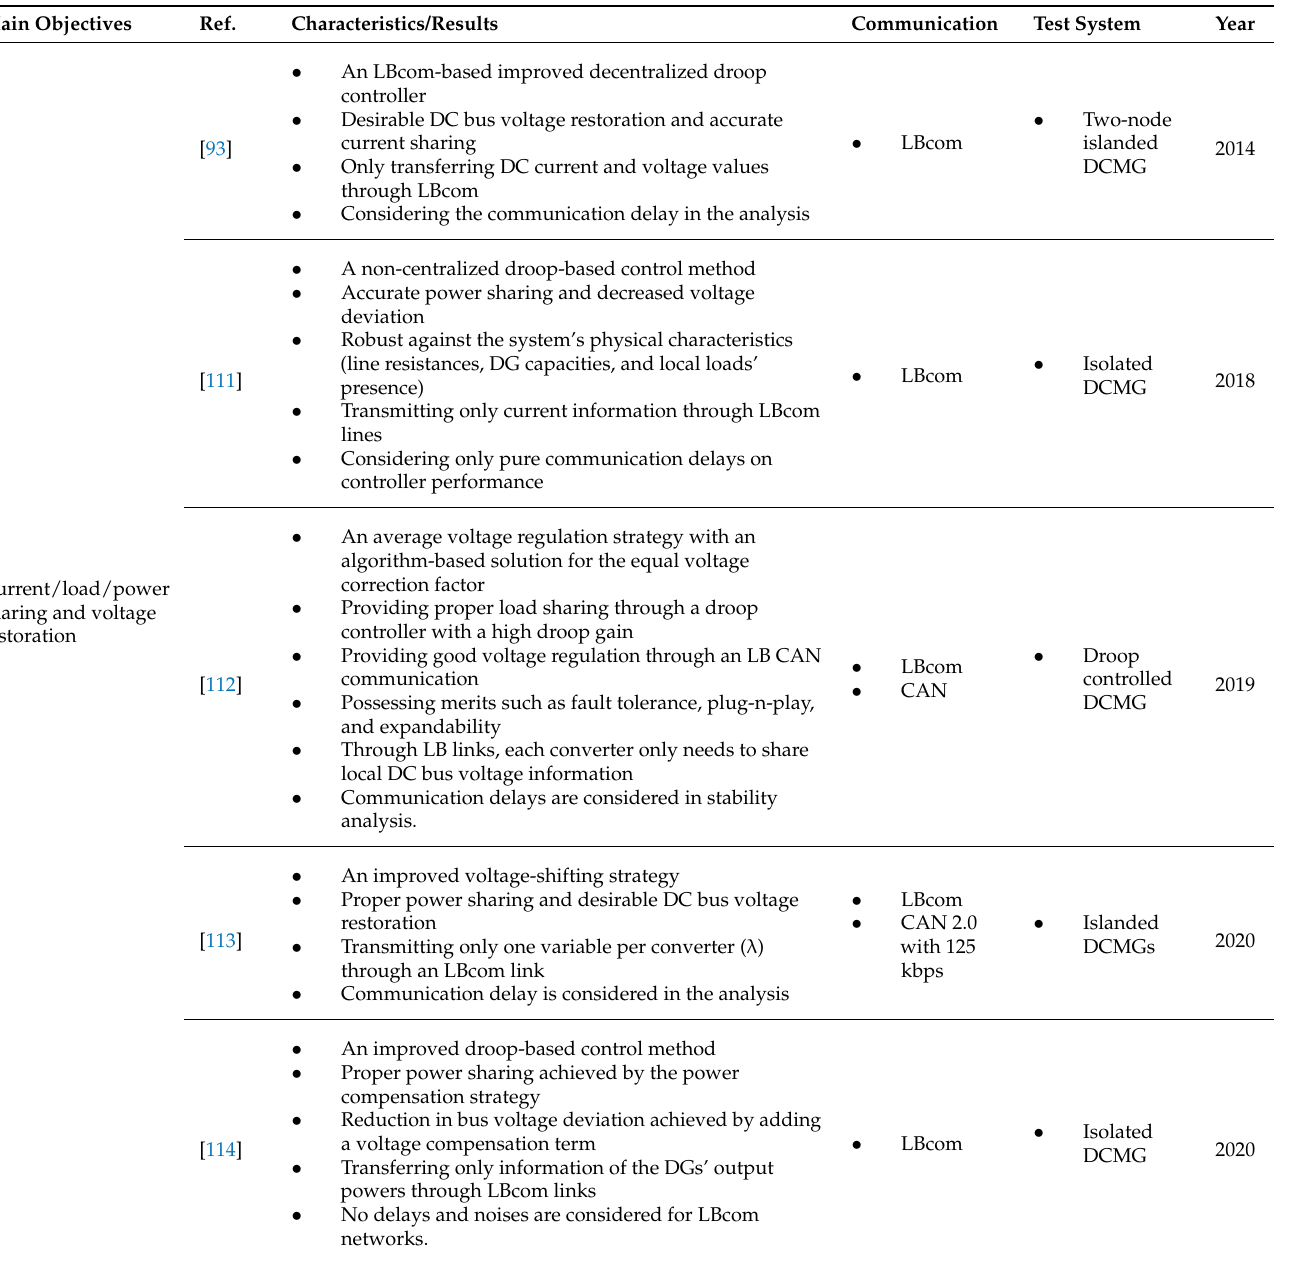
Table 14. Summarizing and categorizing important LBcom-based control methods in the secondary control